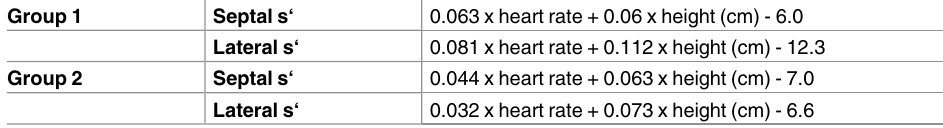
Table 7. Equations for s‘ based on heart rate and height in Groups 1 and